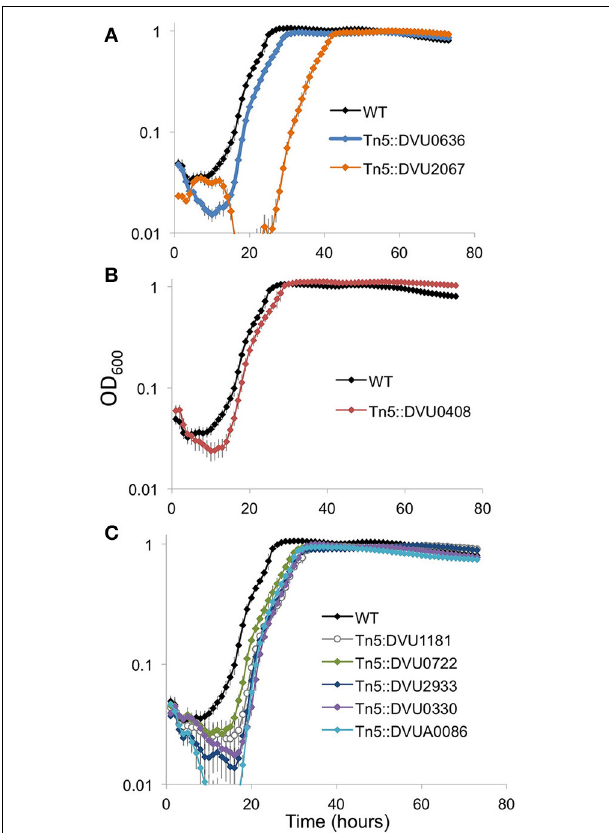
FIGURE 8 | Growth on LS4D for the transposon insertion mutants. Transposon mutants in the two GGDEF domain RR genes (A) , the GGDEF-EAL RR (B) , and the five HD domain RR genes (C) were compared to WT during growth on LS4D. Error bars indicate standard deviations ( n = 4